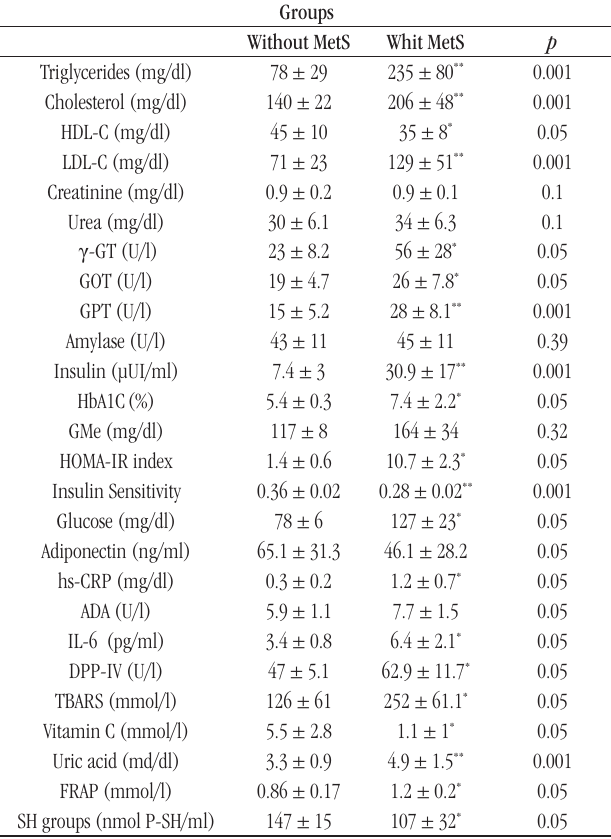
taBLE 2 − Biochemical, oxidative and inflammatory characteristics of the experimental